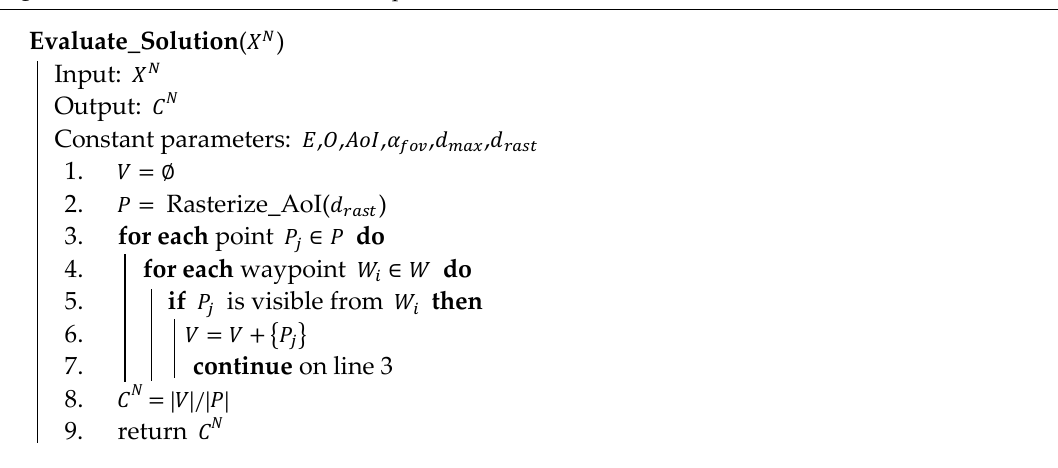
Algorithm 1 Evaluation of a solution in pseudocode